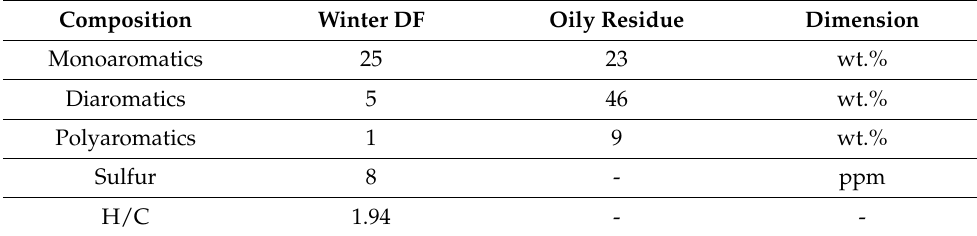
Table 2. Qualitative and quantitative analysis of winter diesel fuel and oily residue [91].